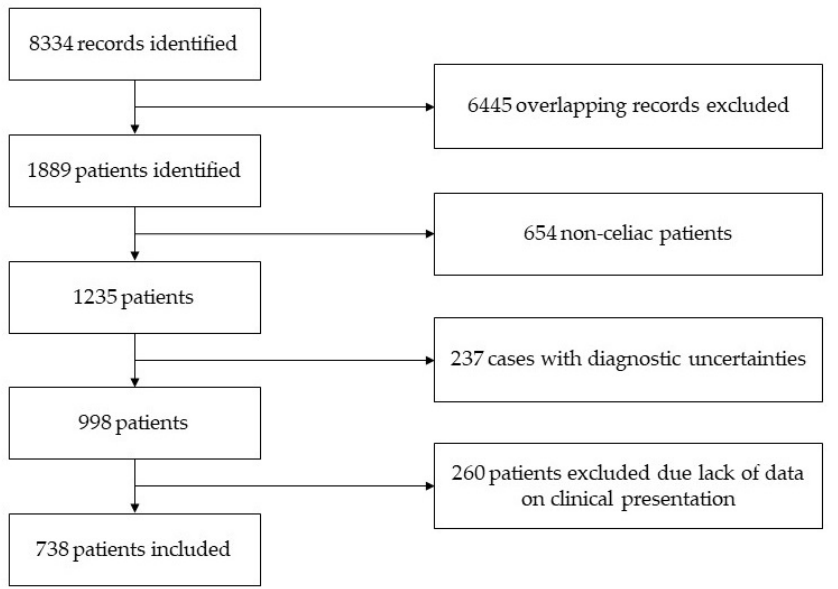
Figure 1. Flow chart of the study.